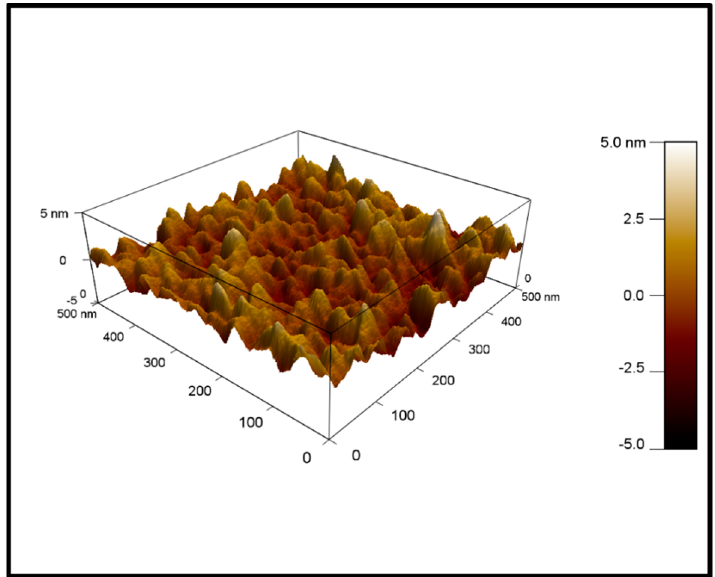
Figure 5. AFM image of cobalt nanofilm deposited on the silicon microreactor .